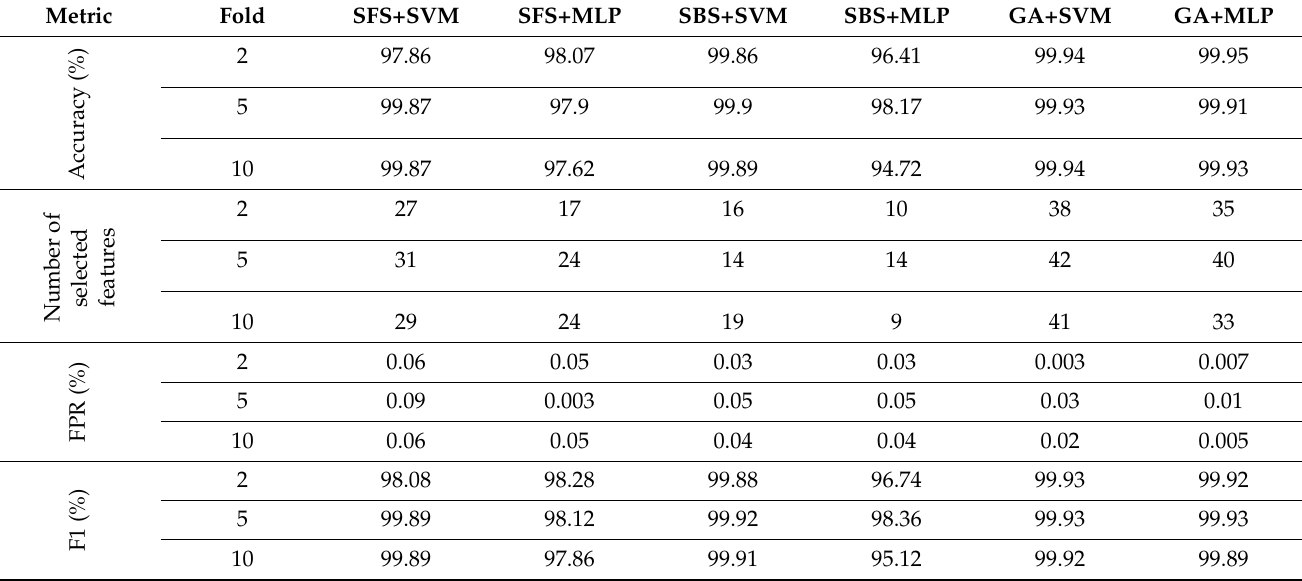
Table 10. Performance of SFS, SBS, and GA using objective function based on DR, FPR, and number of selected features in CIC-IDS-2017.